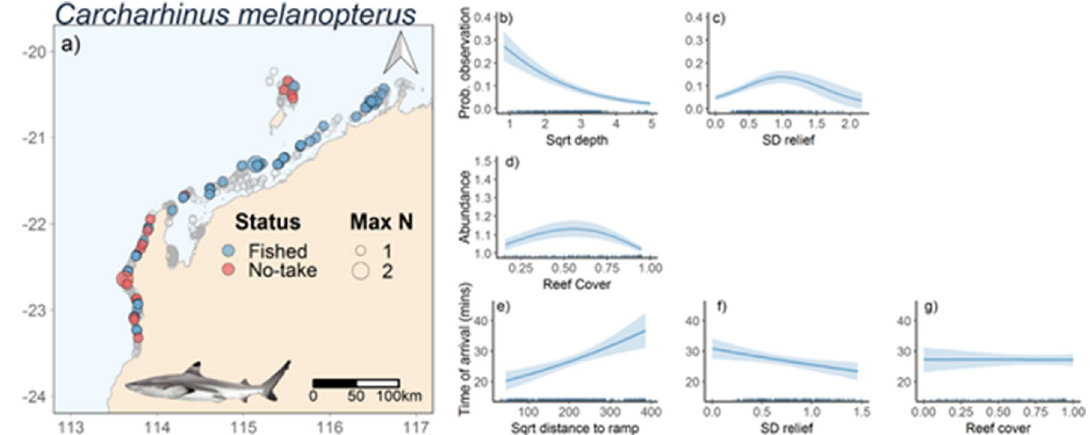
Figure 5. Map of stereo-BRUVS deployments in north-west Australia (indicated by grey open circles. Colour of circles indicates whether the stereo-BRUVS was deployed inside a No-Take Area (red) or in an area where fishing is permitted (Blue). Size of the circle shows the MaxN of Carcharhinus melanopterus in each deployment ( a ). Predicted C. melanopterus probability of occurrence ( b , c ), abundance (MaxN; d ) and time of arrival on BRUVs ( e , f , g ) as functions of variables present in the most parsimonious models (Table 2) from full-subsets GAMM analysis. Ribbons and error bars represent 95% confidence intervals. Figure was generated using R 14 using ggplot2 15 and ggmap 16 .